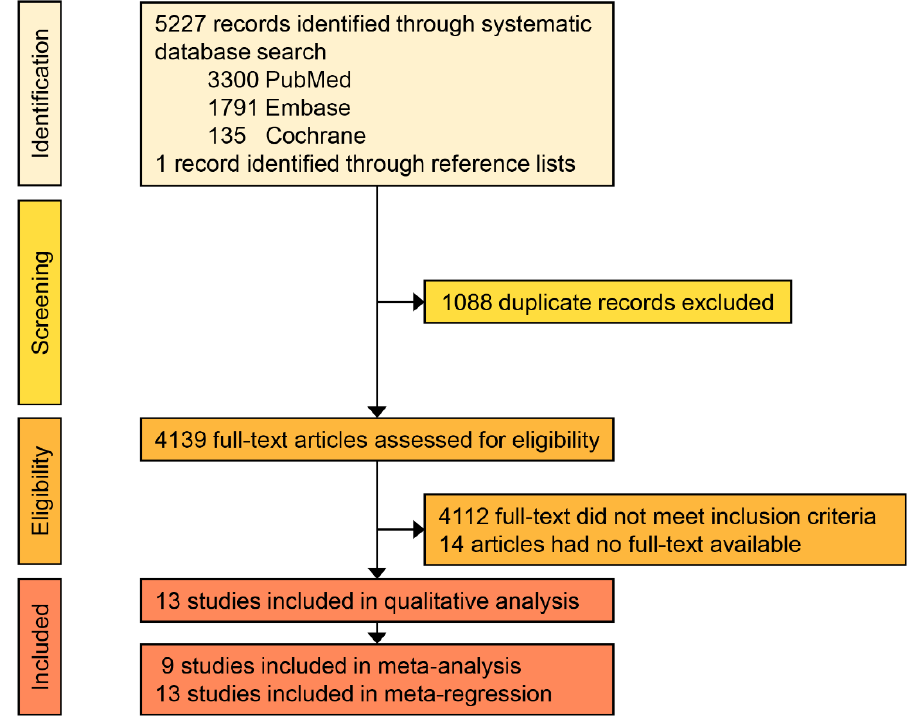
Figure 1. PRISMA flowchart illustrating the study selection.